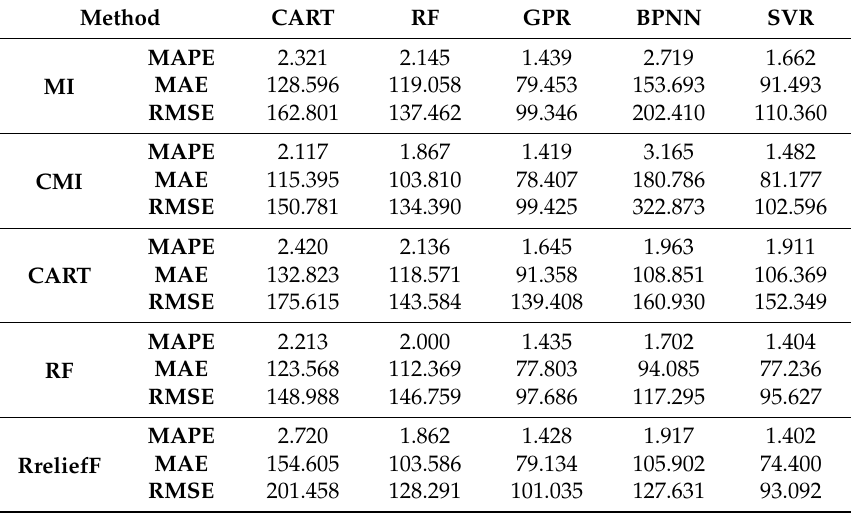
Table 11. Comparison of different combined methods.